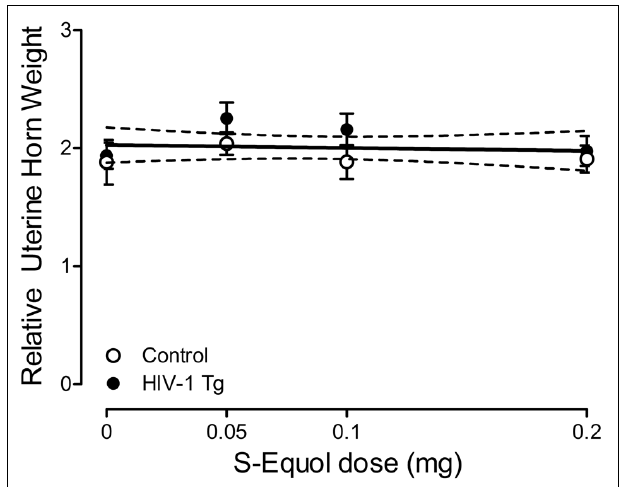
FIGURE 7 | Peripheral effects of S-Equol (SE) were examined by assessing the relative uterine horn weight [i.e., uterine weight (g)/by body weight (g)]. There was no significant effect of genotype ( p > 0.05) or SE dose ( p > 0.05) on relative uterine weight, suggesting that SE most likely exerts its effects